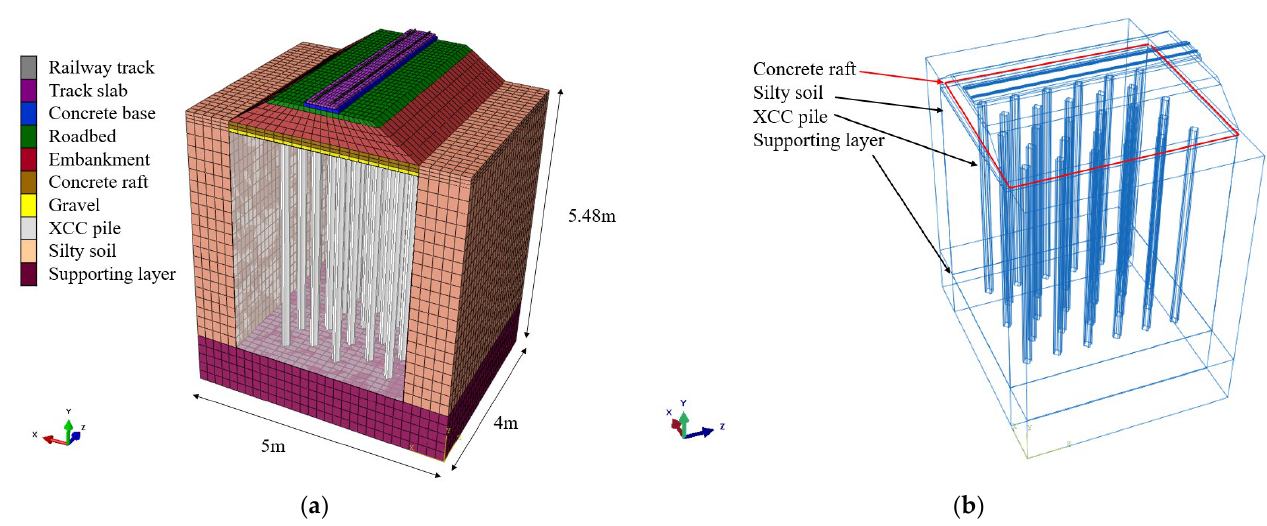
Figure 15. Finite element model of the pile–raft composite foundation. ( a ) finite element mesh, ( b ) wireframe of the model. Table 9. Material parameters of the dynamic loading test.